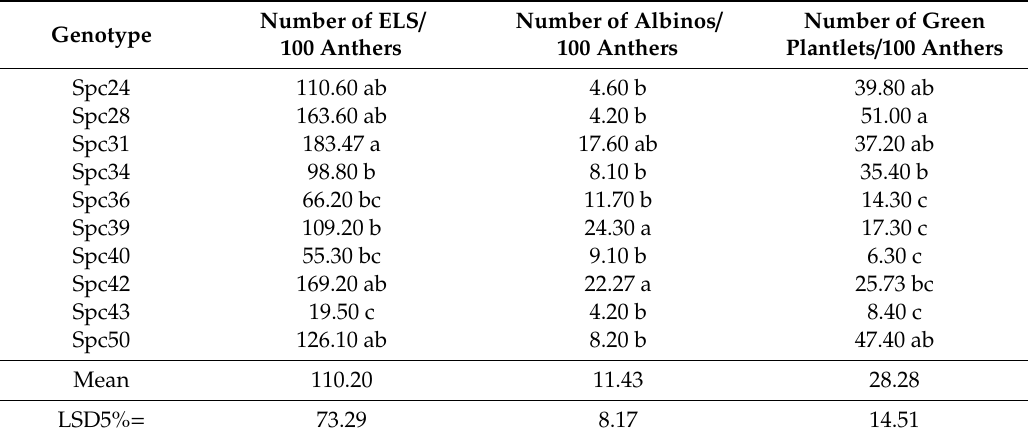
Figure 1. ( a ) Uninucleate microspores at the induction of androgenesis (bar = 10 µ m). ( b ) Microspore-derived ELS developed in anther culture after four weeks of cultivation (bar = 5 mm). ( c ) The ELS produced green- and albino plantlets on the regeneration medium (bar = 10 mm). ( d ) The green plantlets were rooted in individual glass tubes, ( e ) which acclimatized to the greenhouse conditions. Table 8. E ffi ciency of anther culture in ten breeding-orientated F 1 spelt genotypes. Values with the same capital letters are not significantly di ff erent ( p >